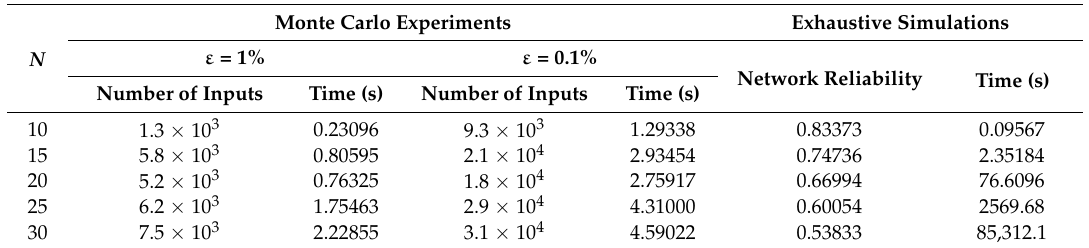
Table 2. Comparison between Monte Carlo and an exhaustive